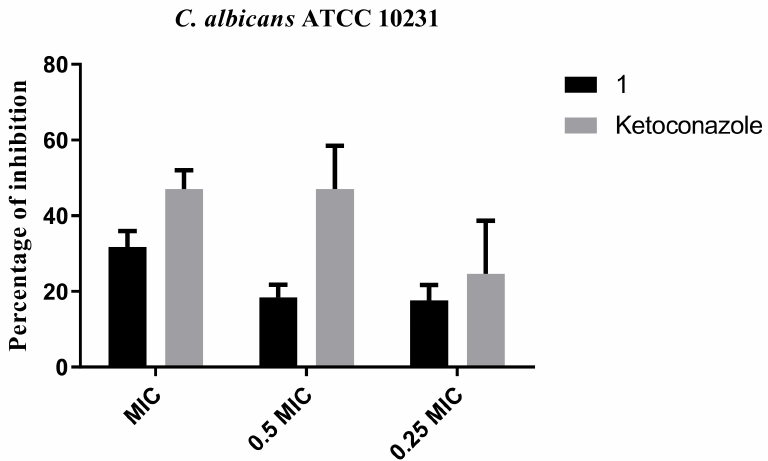
Figure 2. Percentages of inhibition of C. albicans ATCC 10231 biofilm formation by compound 1 and Ketoconazole.